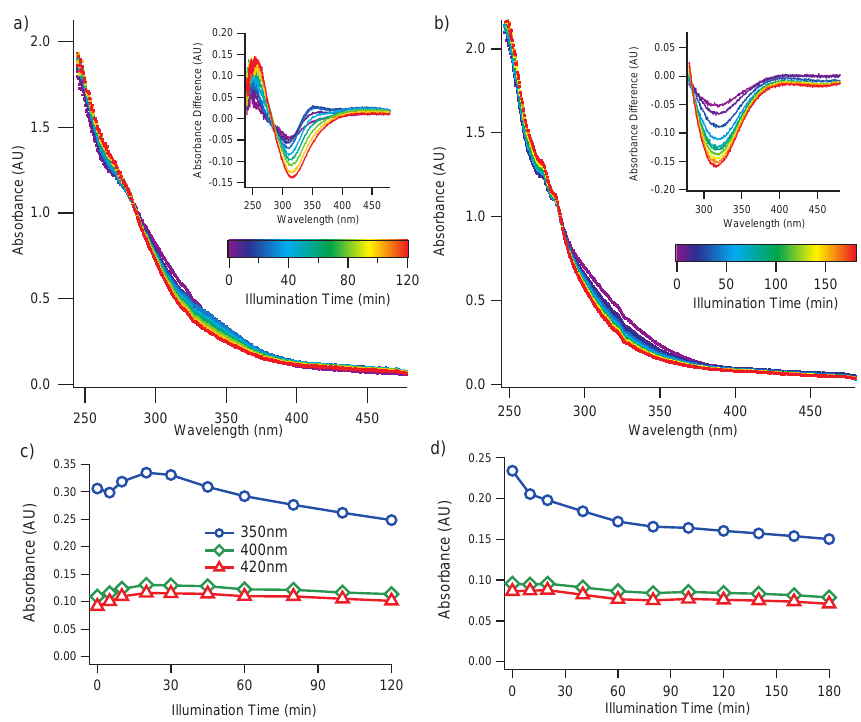
Figure 10. Direct photolysis of the WSOC from biofuel combustion samples. The spectral evolution of the kaoliang and the cotton samples is shown in (a) and (b) , respectively. The color code indicates illumination time, while the insets show the absorbance change compared to the initial condition. The time profiles of absorbance at three different wavelengths for the same samples are shown in (c) and (d) , respectively.